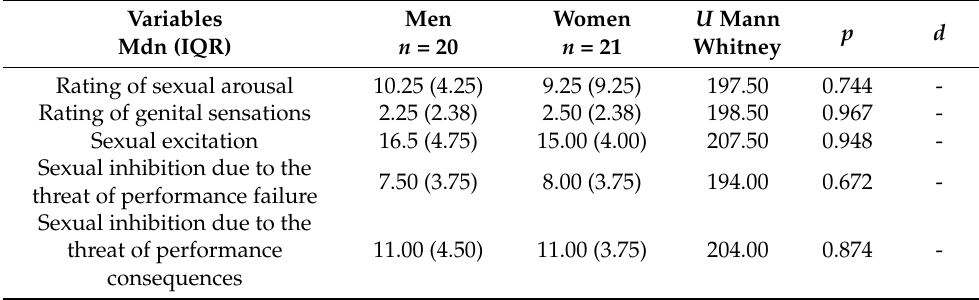
Table 5. Differences by sex in sexual